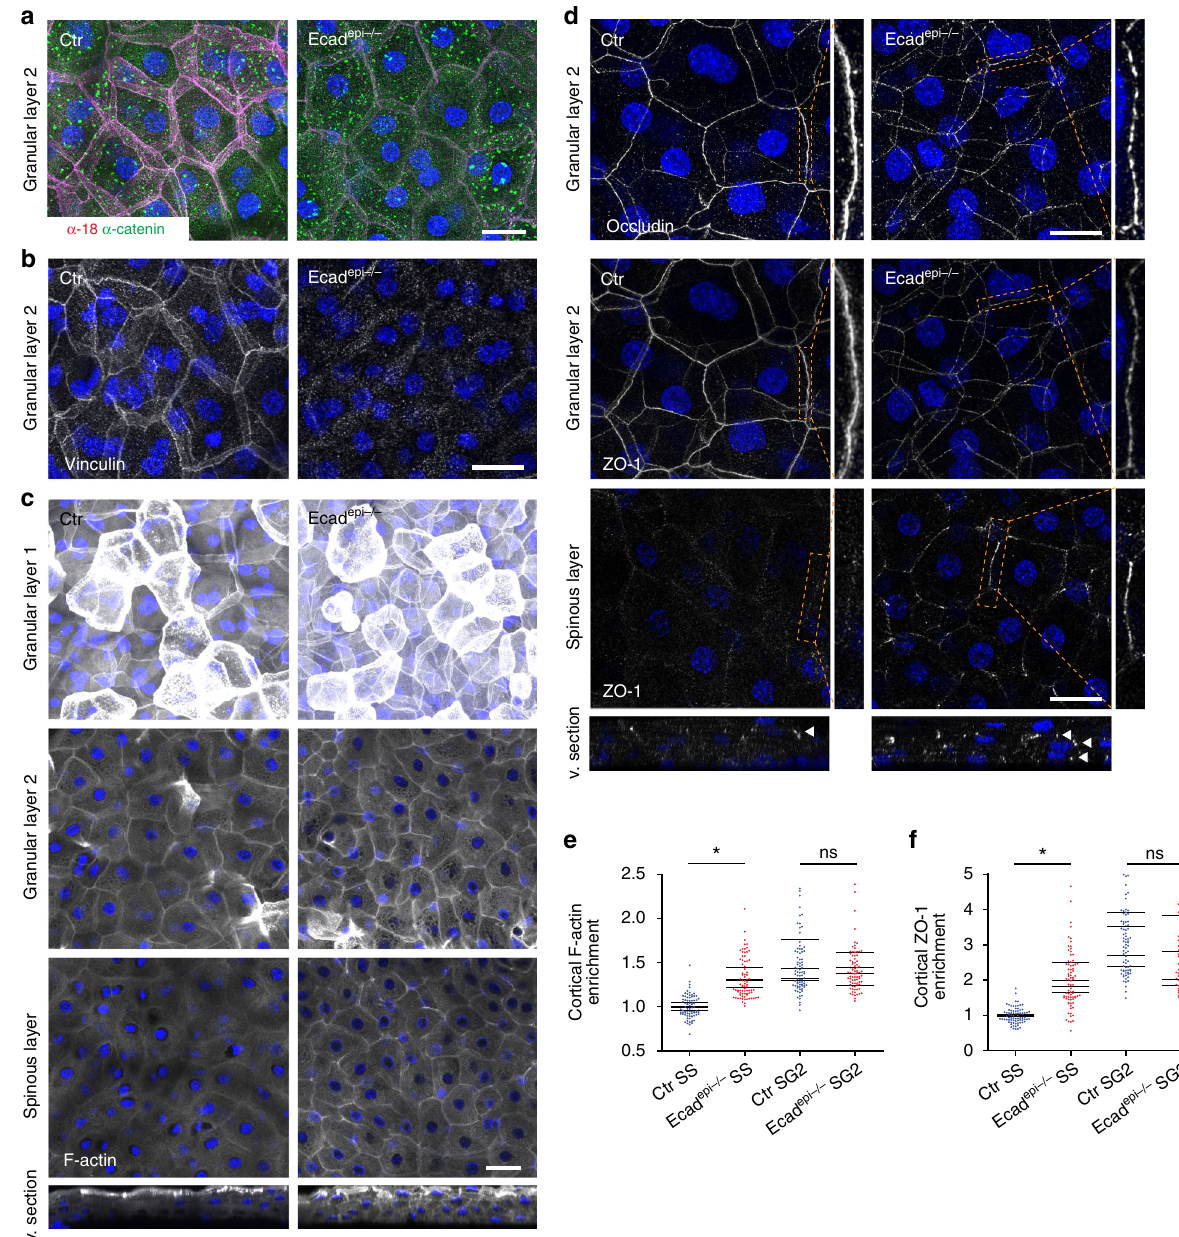
Fig. 3 E-cadherin regulates tissue polarization of mechanosensitive junctions and cytoskeleton. a Newborn epidermal whole-mount immuno fl uorescence analysis for tension-sensitive epitope ( α 18) and total α -catenin and b Vinculin showing loss of α 18 and vinculin and strong reduction in total α -catenin in granular layer 2 (SG2) of Ecad epi − / − . Scale bar, 20 µ m. c F-actin staining (Phalloidin) showing that loss of E-cadherin results in less F-actin polarization across layers. Scale bar, 30 µ m. d ZO-1 and occludin staining showing interrupted TJs in SG2 and increased punctate ZO-1 in lower layers upon loss of E-cadherin. Scale bar, 20 µ m. a , b – d Partial confocal stack projections and virtual sections (v. sections) from newborn mouse epidermal whole mounts. Stacks shown in a were deconvolved. a , b – d Representative images of n ≥ 3 biological replicates each. Nuclei were stained with DAPI (blue). e Quanti fi cation of F-actin intensities from c normalized to Ctr spinous layer (SS). 20 measurements (dots) per biological replicate and the mean (lines) of each biological replicate are shown, * P = 0.0308; n = 4 biological replicates with Kruskal – Wallis, Dunn ’ s post hoc test. f Quanti fi cation of layer speci fi c cortical ZO-1 enrichment normalized to Ctr SS. 20 measurements (dots) and the respective means (lines) of four biological replicates are shown, ns = not signi fi cant, * P = 0.0286; n = 4 biological replicates with Mann – Whitney